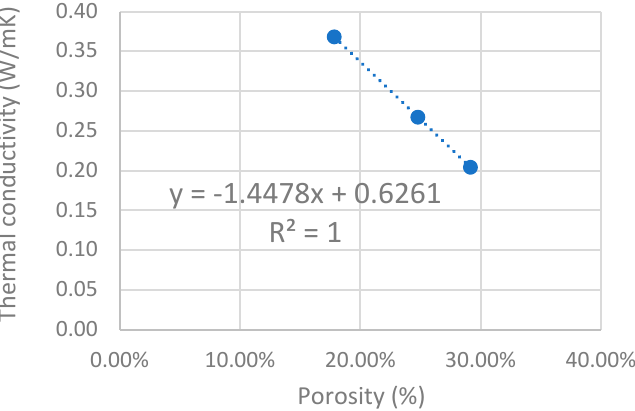
Figure 12. Correlation of vermiculite content, thermal conductivity, and porosity results from the study by Palomar et al. (2015) [44].